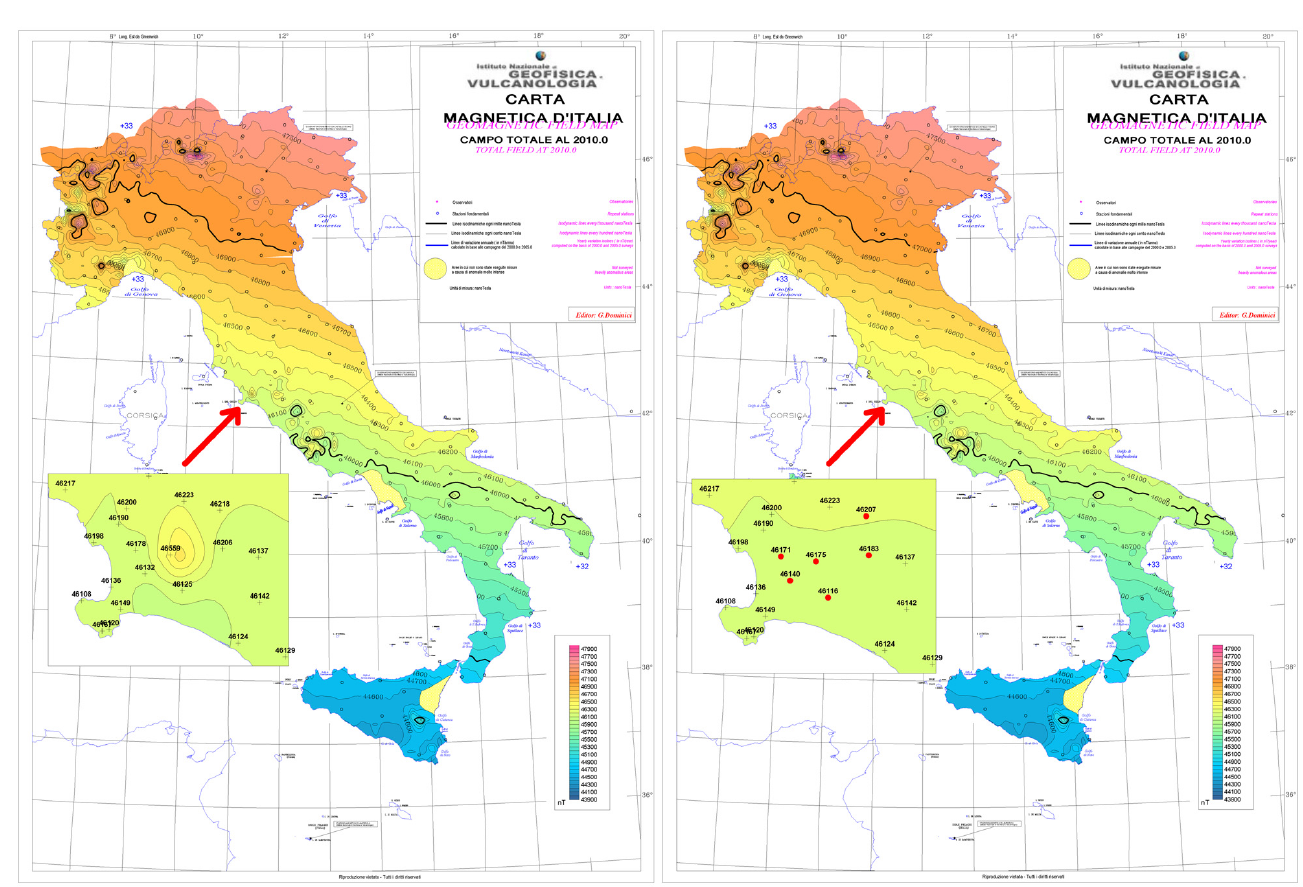
Figure 4. Left: map of total field F at 2010.0, before the revision in the Albegna basin. Right: map of F at 2010.0, corrected after re-measured data in local survey (red point in the